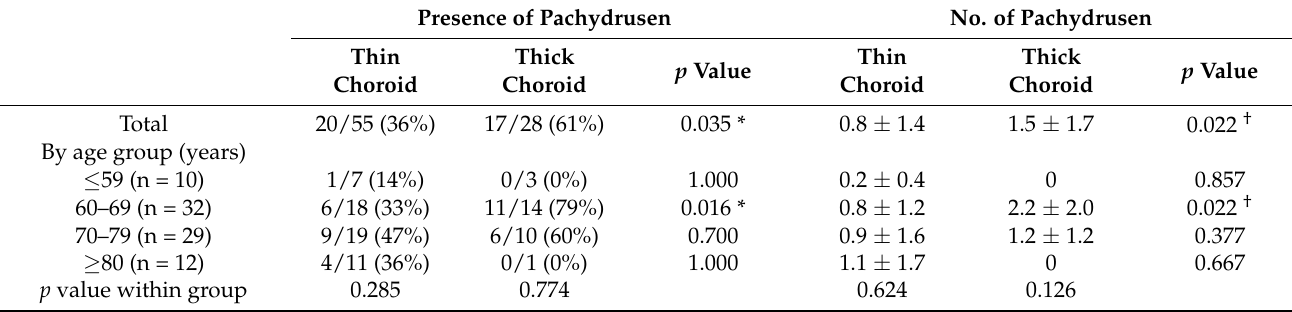
Table 2. OCT-related factors of included eyes with PCV stratified by age.